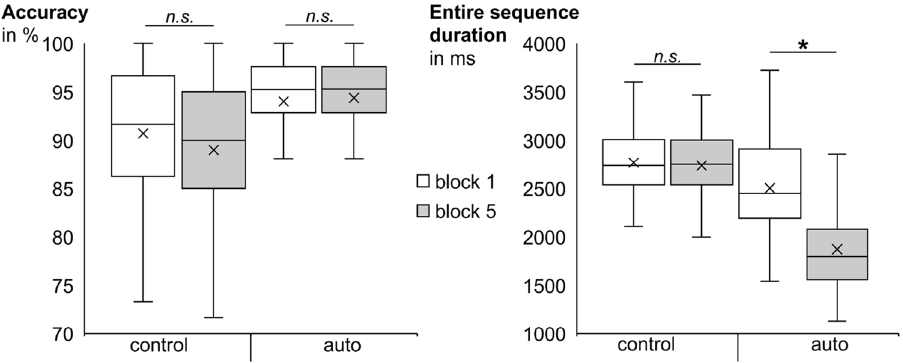
Figure 1. Illustration of the task effects in accuracy (in percent, left graph) and entire sequence duration (ESD, i.e., the time between stimulus onset and the last response in milliseconds, right graph). We observed significantly more accurate and faster responses in the auto condition than in control condition. For ESDs, we also observed significantly shorter durations in block 5 than in block 1. Most importantly, the size of the learning effect (block 1 minus block 5) was significantly larger in the auto condition (where automatization of the entire motor sequence was possible over the course of the experiment), than in the control condition (where this automatization was not possible). n.s. = non-significant; * = p <